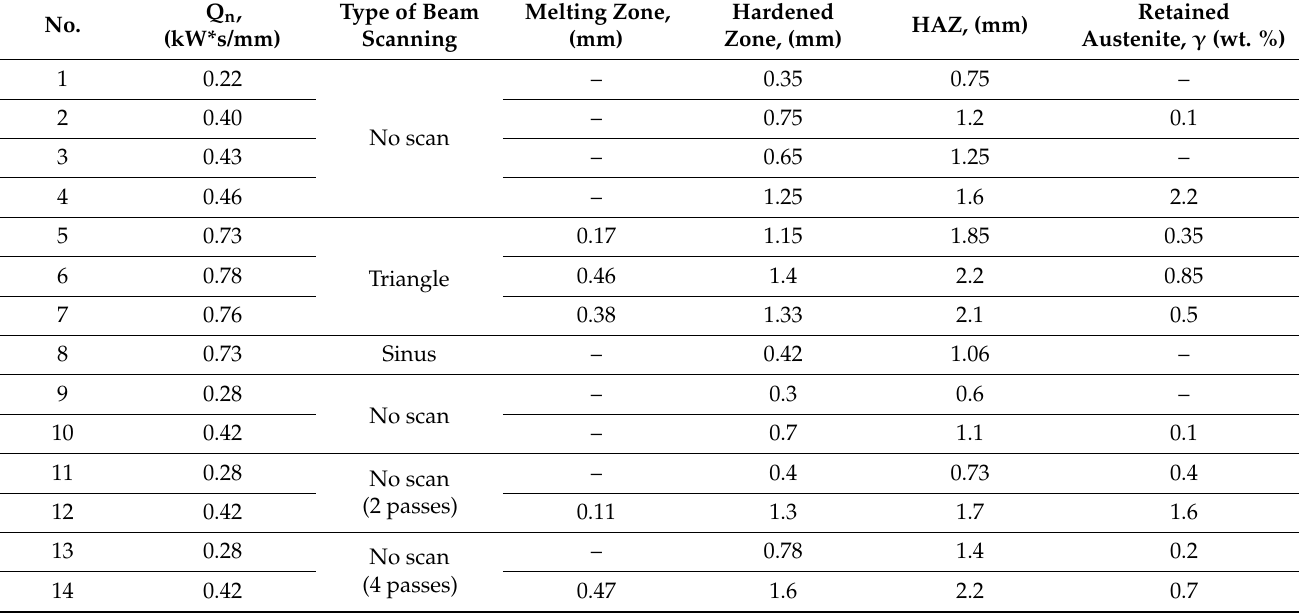
Table 4. Influence of the linear energy on the depth of hardened layer and structural